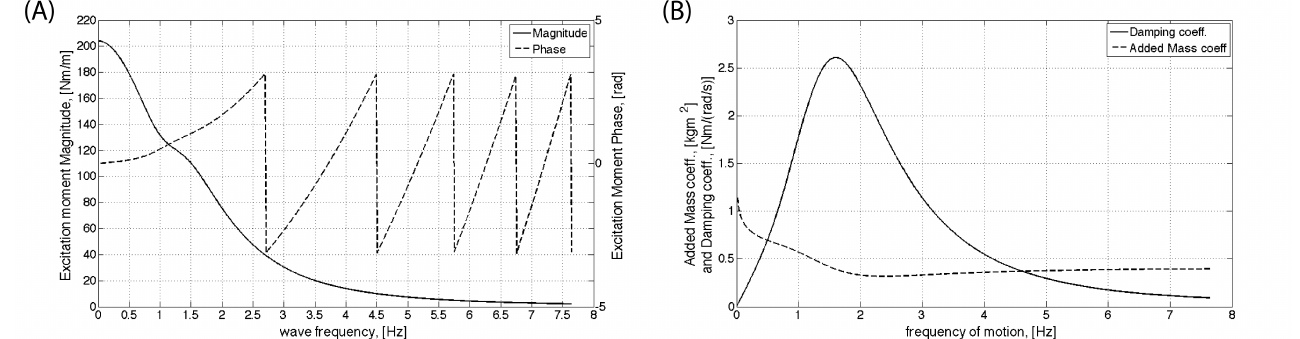
Figure 3. Hydrodynamic frequency response functions for the Wavestar model: ( A ) bi-axis plot of the wave excitation moment magnitude coefficients (solid line) and phase coefficients (dotted line); and ( B ) plot of the radiation moment damping coefficients (solid line) and added mass coefficients (dotted line).